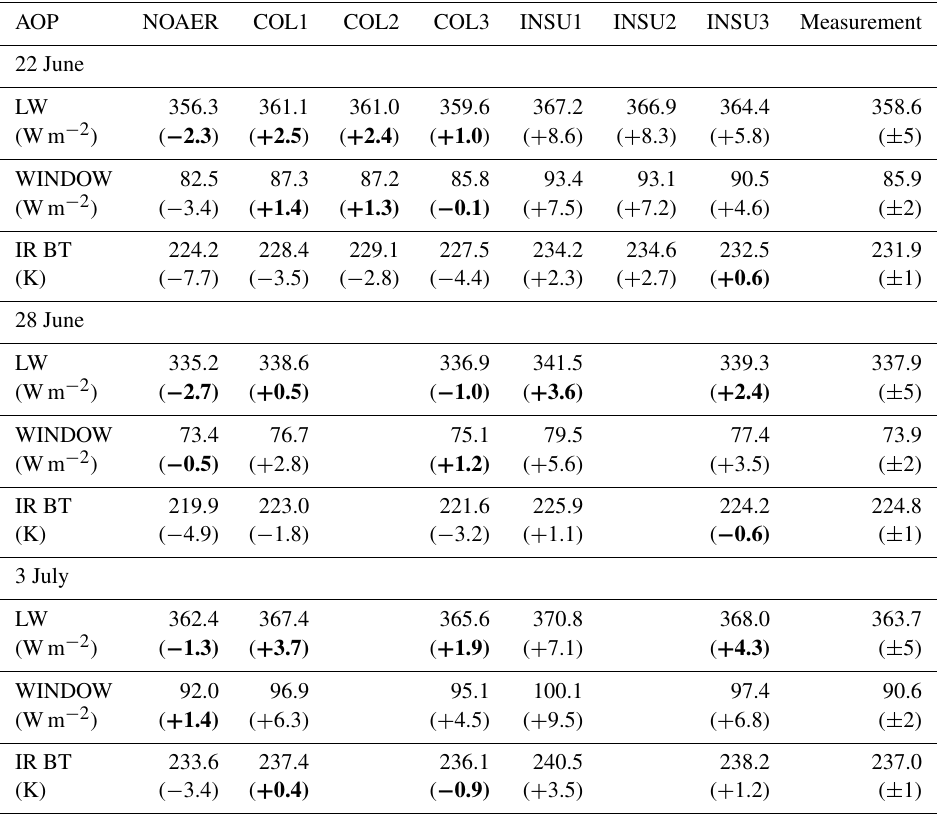
Table 3. Measured and simulated downward LW and WINDOW irradiance and sky BT at the surface for the three analysed cases; model calculations are performed with different AOPs. The expanded uncertainty associated with the measurements is shown in parentheses together with the measured values. The model–measurement difference is shown in parentheses together with the modelled values. Differences within the measurement uncertainty are in